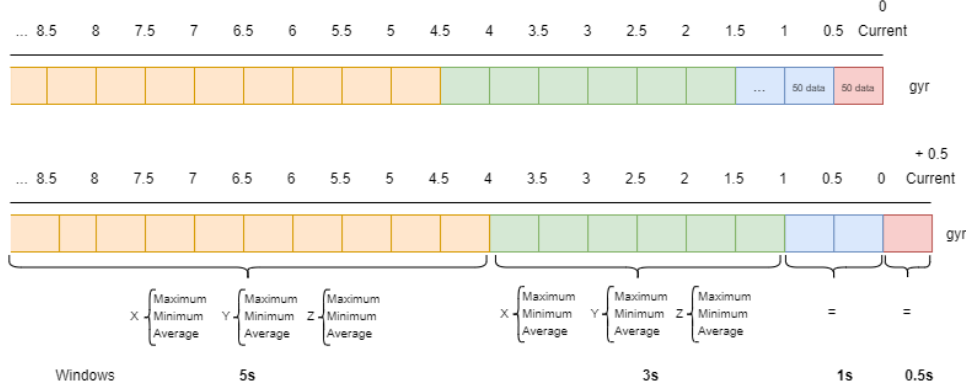
Figure 18. Big windows.